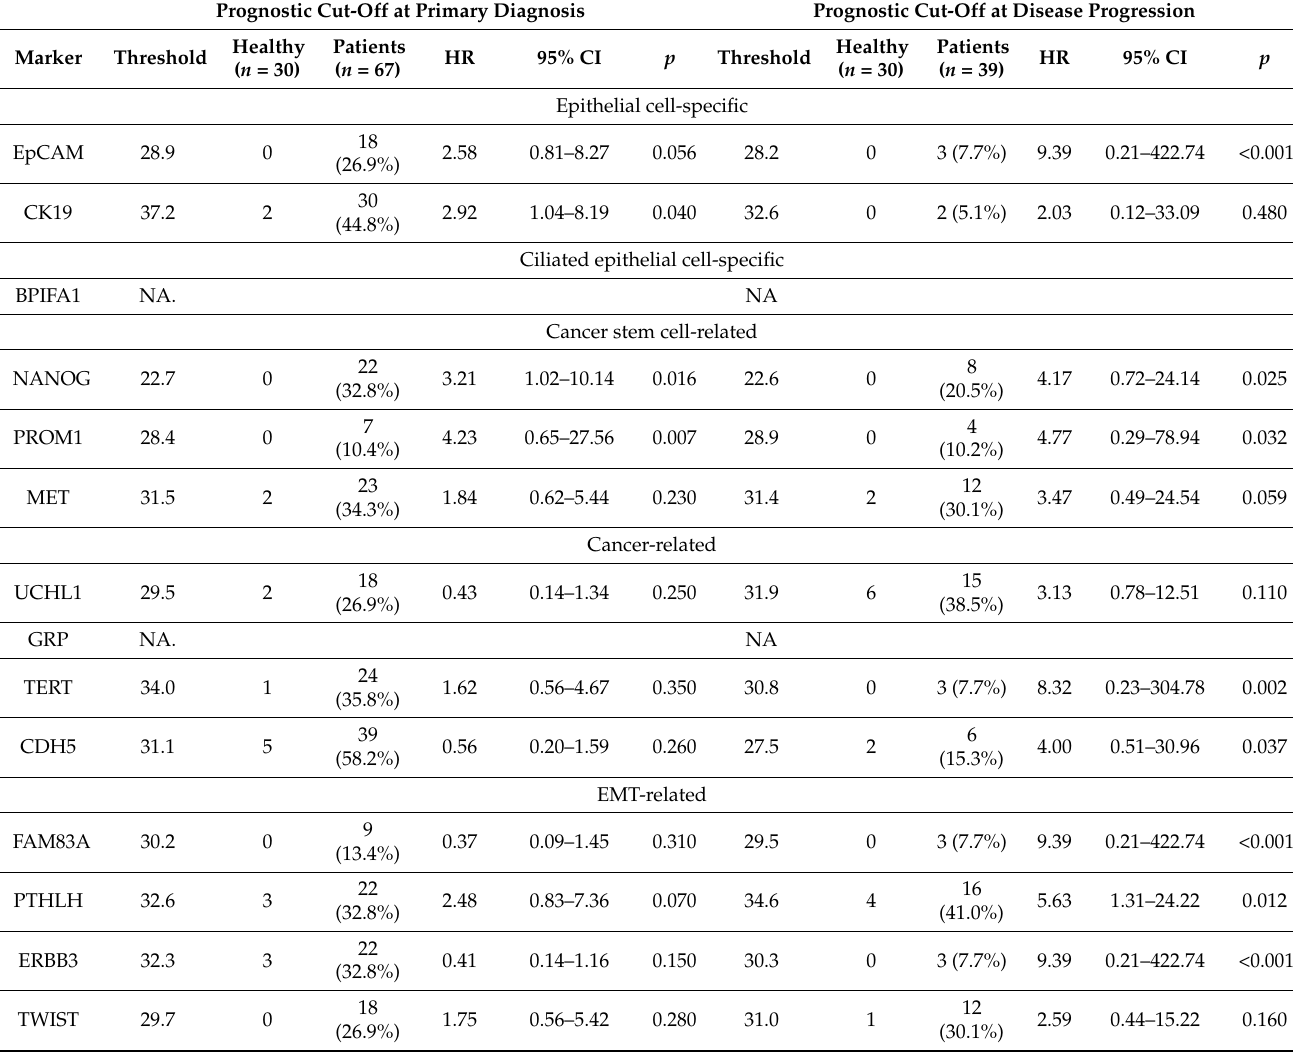
Table 3. Prevalence of gene expression levels beyond the prognostic cut-off threshold levels as assessed for samples taken at primary diagnosis and at progression. The absolute and relative numbers of positive findings beyond these thresholds are shown for the healthy donor group and the respective patient group. Univariate Cox hazards for OS are shown for both groups of patients, each stratified by the prognostic cut-off threshold values of the respective gene